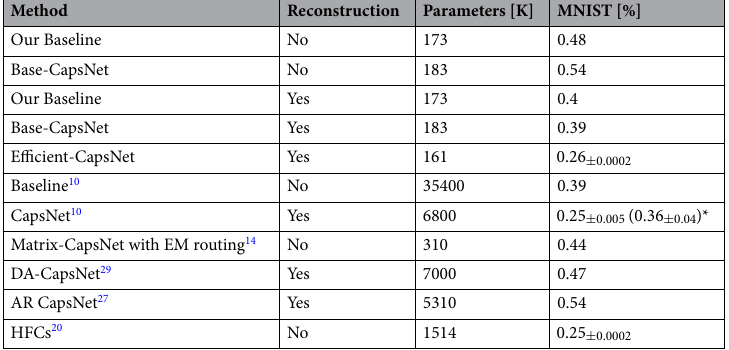
Table 2. Test error (%) on the MNIST classification task. All methodologies are reported with their number of parameters and the presence of the reconstruction regularizer during the training phase. * indicates the results from our experiments.